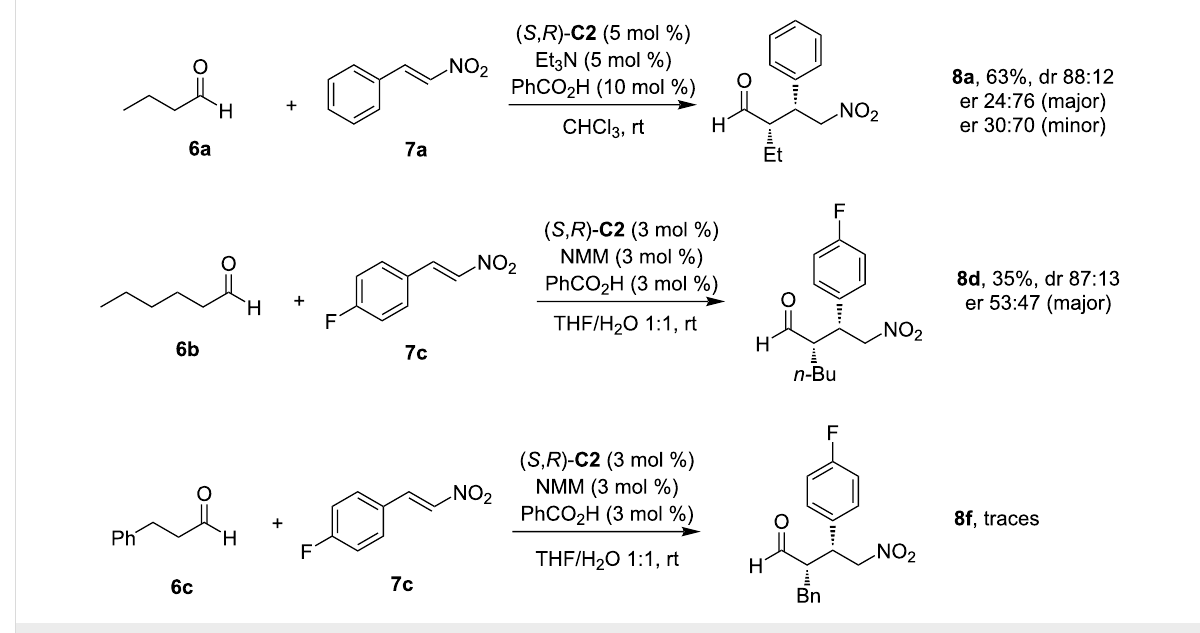
Scheme 3: Synthesis of adducts 8a , d , f in solution.